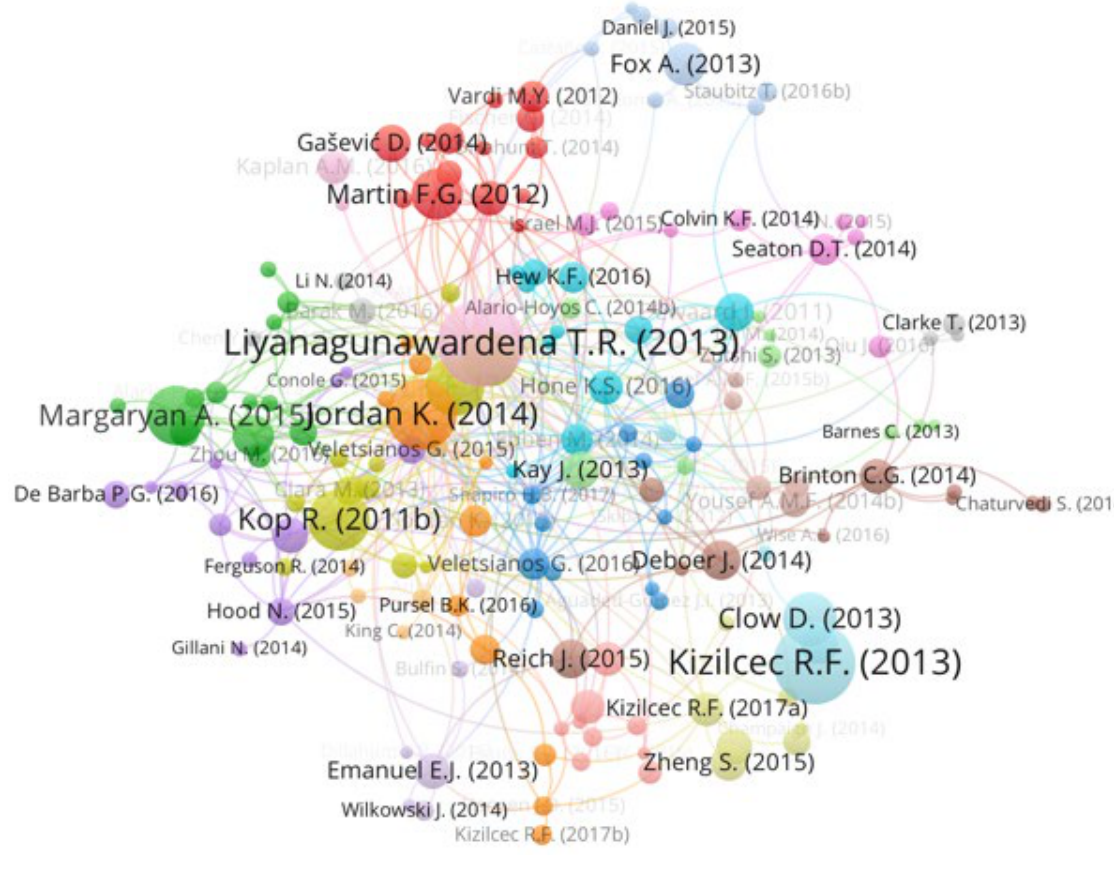
Figure 5. Network visualization map of citations of MOOC